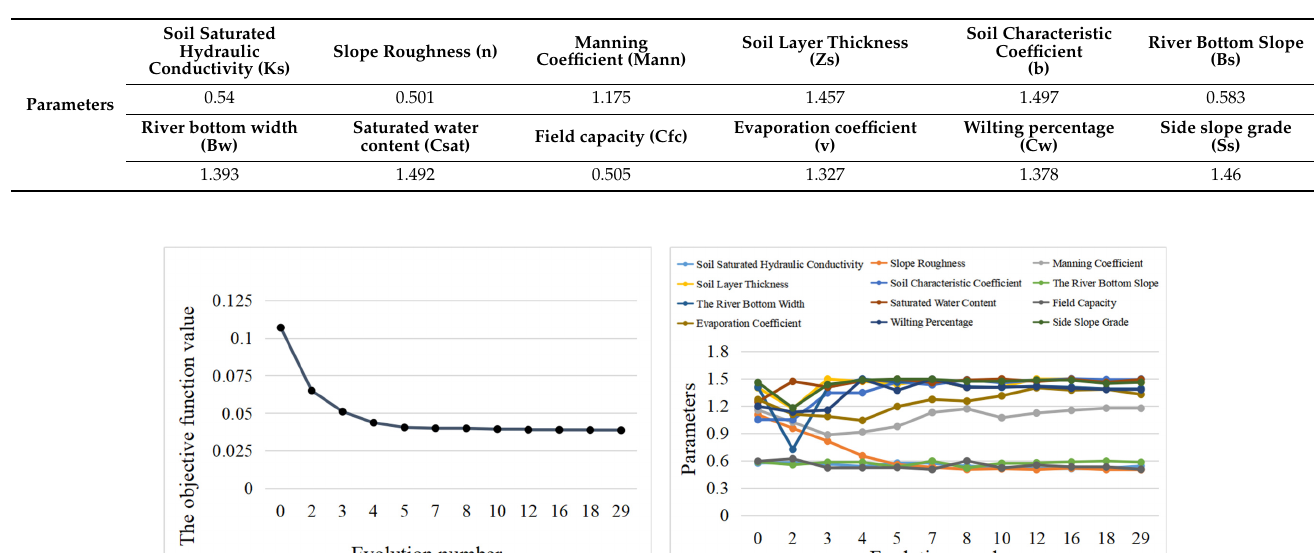
Table 3. Parameter optimization results for the Liuxihe model.